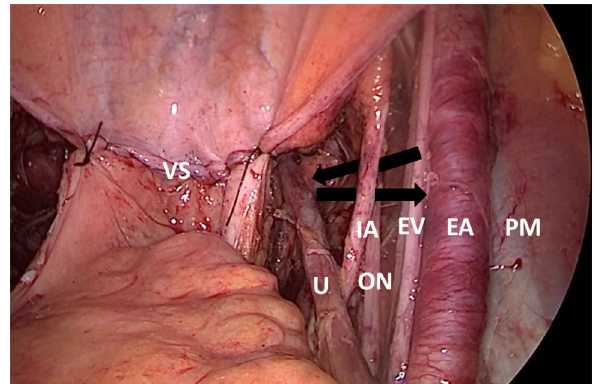
Figure 1. Operative findings of pelvis at the end of surgery. Internal iliac, external iliac, obturator, common iliac vessels, and obturator nerves and ureters were completely skeletonized. The retroperitoneum was left open. Arrows indicate a representative IBSPP hernial orifice. PM, Psoas muscle; EA, External iliac artery; EV, External iliac vein; IA, Internal iliac artery; ON, Obturator nerve; U, Ureter; VS, vaginal stump covered by peritoneum. This figure was drawn by corresponding author using Microsoft PowerPoint 2013 (https ://www.micro soft.com/ ja-jp/micro soft-365/previ ous-versi ons/micro soft-power point